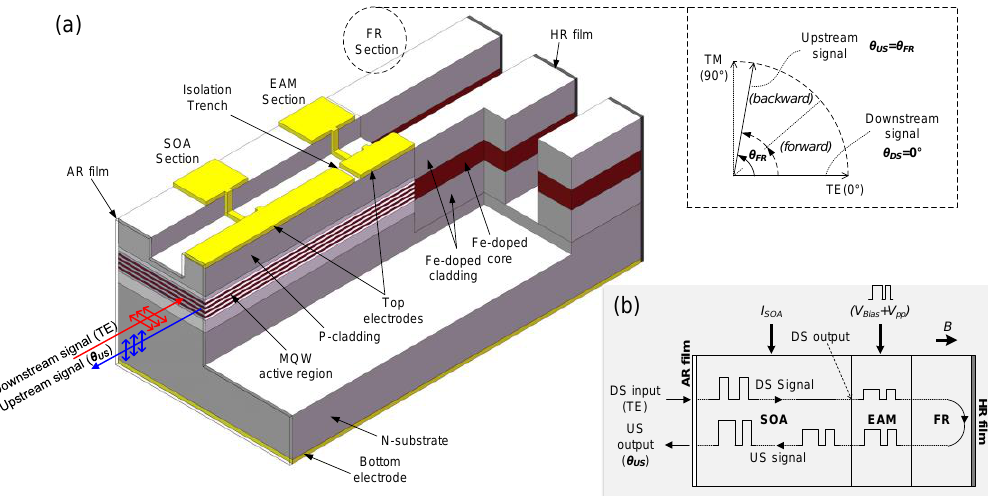
Figure 1. ( a ) Schematic three-dimensional view of the proposed polarization-discriminated (PD) reflective semiconductor optical amplifier electro-absorption modifier (RSOA–EAM), and ( b ) Schematic diagram for the device operation. ( θ DS : polarization angle of the input downstream signal; θ US : polarization angle of the input upstream signal; θ FR : the round-trip Faraday rotation angle; HR: high reflective; AR: antireflective; DS: downstream; US: upstream).